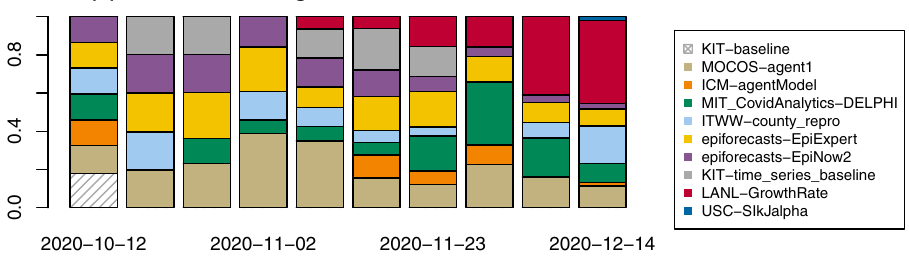
Fig. 6 Examples of inverse WIS weights. Inverse-WIS (weighted interval score) weights for forecasts of incident deaths in ( a ) Germany and ( b )